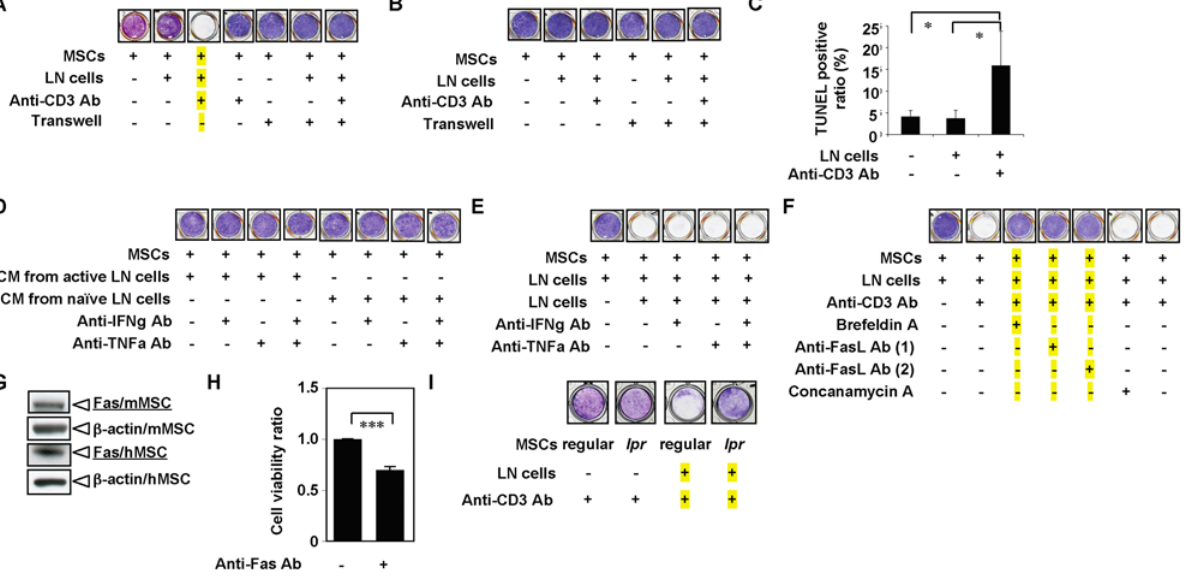
Figure 1. Lymph node (LN) cells activated by an anti-CD3 antibody induce BMMSC apoptosis invitro . ( A ) Mouse BMMSCs co-cultured with LN cells indicated that anti-CD3 antibody activated LN cells were capable of inducing BMMSC death as shown a blank well without BMMSC staining (blue). When co-cultured BMMSCs (MSC) and LN cells were separated by a transwell culture system, anti-CD3 antibody treated LN cells failed to induce BMMSC death. ( B ) It is known that immunocompromised mice have no T lymphocytes. Thus, LN cells derived from immunocompromised failed to induce BMMSC death following anti-CD3 antibody activation in the co-culture system. ( C ) TUNEL staining showed that BMMSC death caused by anti-CD3 antibody-activated LN cell is through an apoptotic pathway. ( D ) Condition medium (CM) derived from naı¨ve LN cells and anti-CD3 antibody activated LN cells were not able to induce cell death of BMMSCs. ( E ) Neutralizing anti-TNF- a and IFN- c antibodies were not able to inhibit BMMSC death induced by anti-CD3 antibody-activated LN cells. ( F ) Neutralizing Fas ligand antibodies and brefeldin A, but not concanamycin A, were capable of blocking BMMSC death induced by anti-CD3 antibody-activated LN cells. ( G ) Western blot analysis showed that mouse and human BMMSCs (mMSC and hMSC) express Fas. ( H ) Fas antibody can induce significant reduction in number of living BMMSCs in culture. ( I ) Anti-CD3 antibody-activated LN cells were not able to induce cell death of BMMSCs derived from CD95 -deficient mice ( lpr ). (n=5; [ P , 0.05 and [[[ P , 0.005).